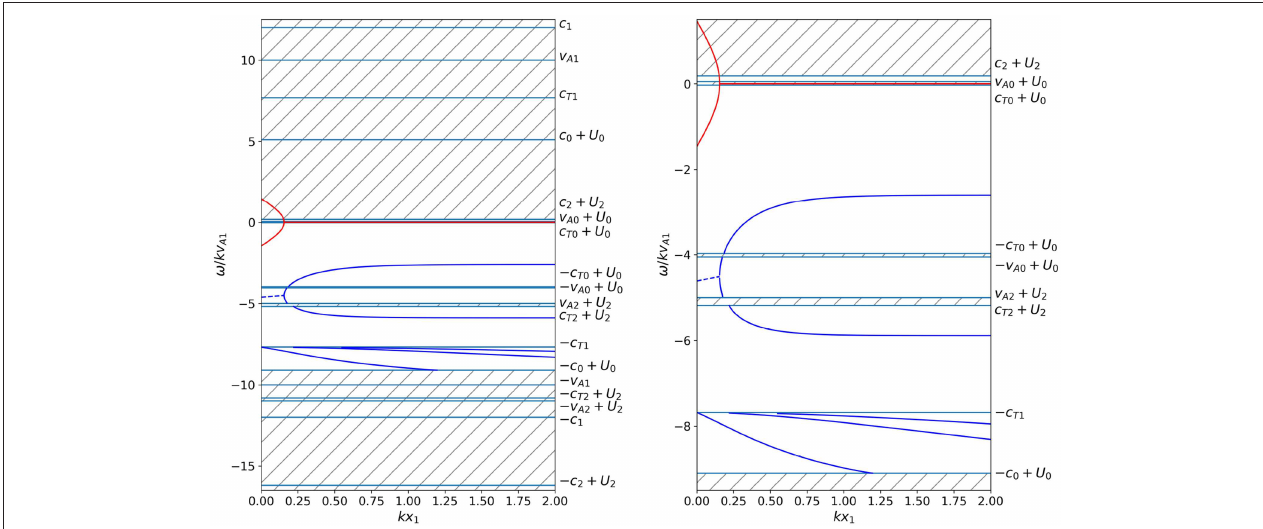
FIGURE 13 | Solutions to the dispersion relation for a high- β MBP. The diagram on the left displays the full range of characteristic speeds, while for the one on the right, the narrower band of interest is enlarged. While in the static case, the characteristic speeds delineate the cut-off frequencies, in a steady slab, these have to be modified by the flow